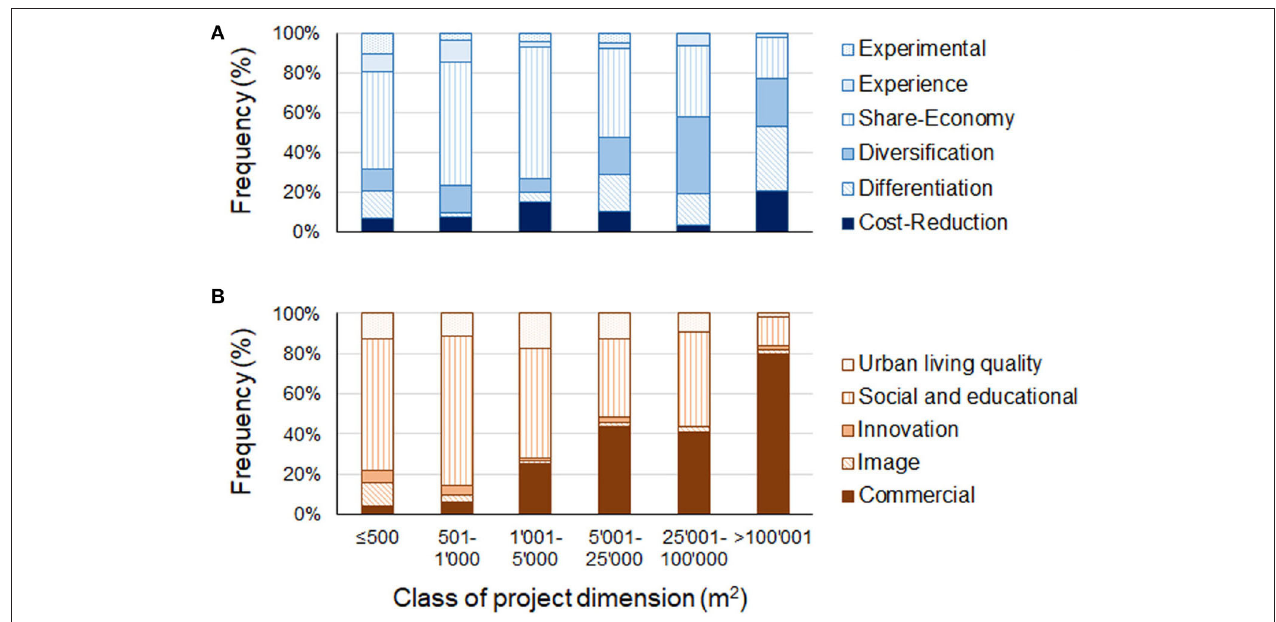
FIGURE 3 | Relative distribution frequency (%) of business models ( A , Pölling et al., 2015, n = 399) and farming purposes ( B , Thomaier et al., 2015, n = 407) with respect to the class of project dimension among the case studies included in the database.